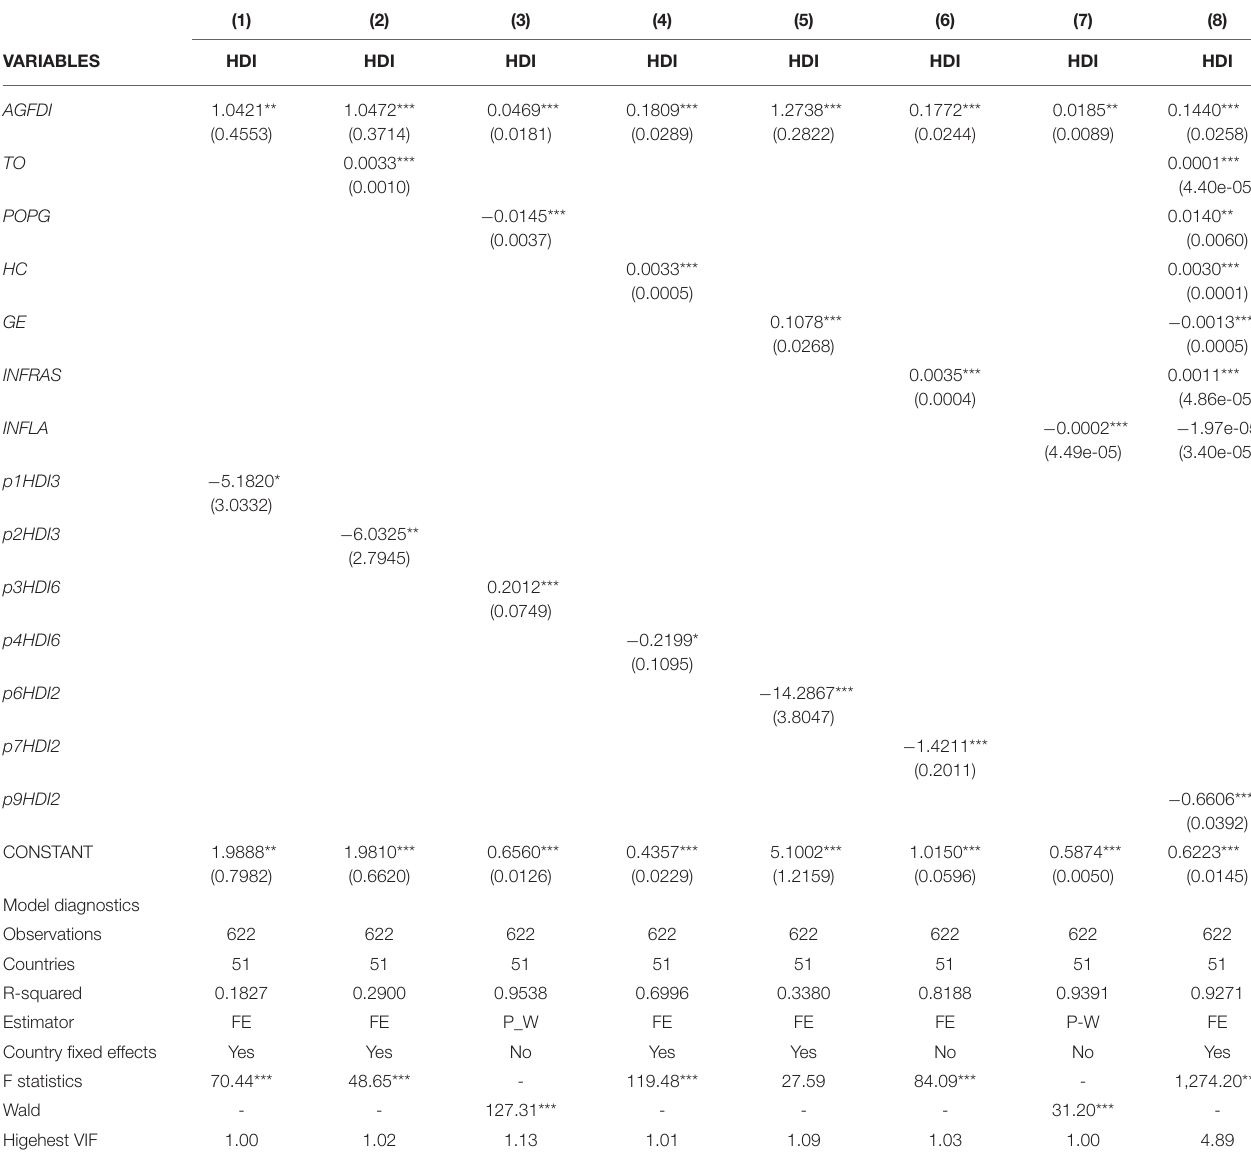
TABLE 3 | Estimations with robustness